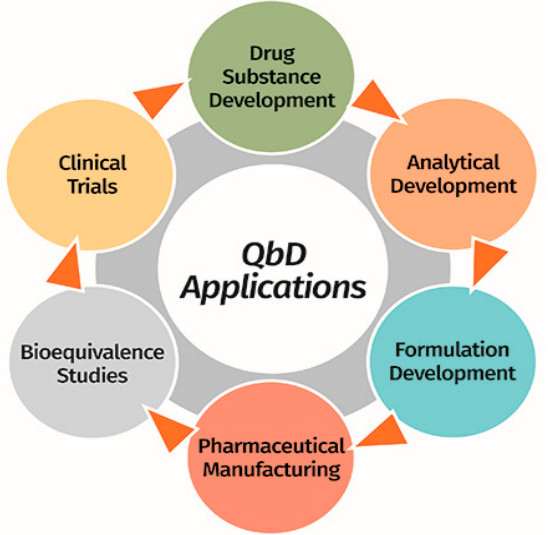
Figure 4. Potential applications of the QbD approach in diverse stages of the Drug development lifecycle. Reprinted with permission from Rahman, M. et al. European Pharmaceutical Review , 22(1). Copyright (2017) Rusell Publishing Limited [39].